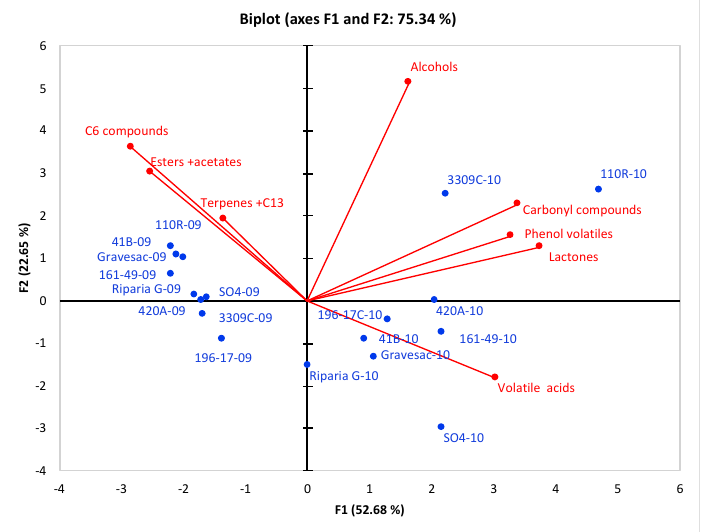
Figure 2. Principal component analysis (PCA) applied to chemical families of volatile compounds quantified in Albariño wine from different rootstocks over two vintages (2009 and 2010).